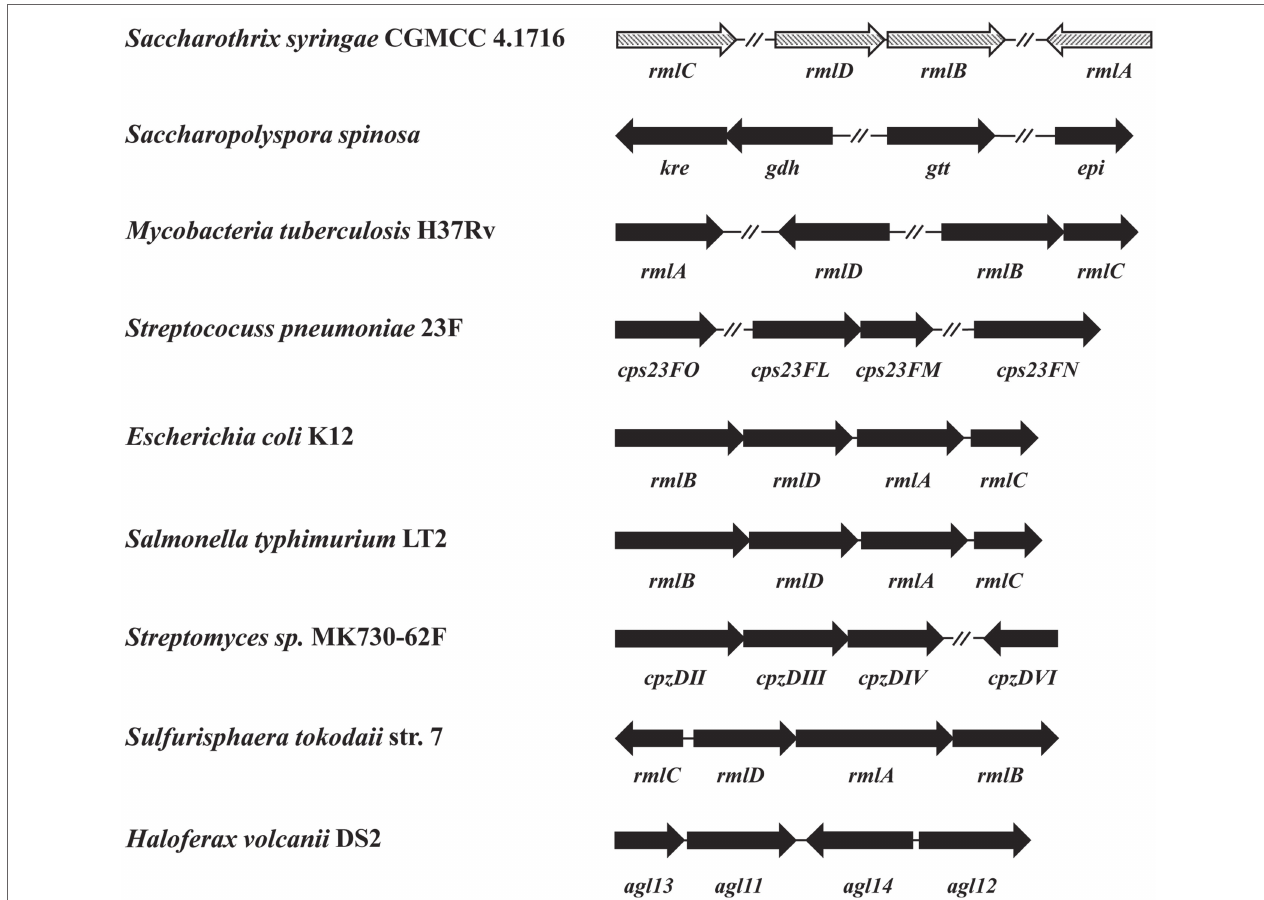
FIGURE 2 | Comparison of nine sets of rmlABCD genes for genomic organization. The sequences for analysis were from Saccharothrix syringae CGMCC 4.1716, Mycobacteria tuberculosis H37Rv (Genbank accession no. NP_214848, NP_217981, NP_217982, and NP_217783) , Saccharopolyspora spinosa (Genbank accession no. AAK83289, AAK83290, AAK83291, and AAK83291), Streptococcus pneumoniae 23F (Genbank accession no. AAZ51352, WP_011285494, WP_012560640, and AAZ51220), E. coli K12 (Genbank accession no. AAB88400, AAB88398, AAB88401, and AAB88399), Salmonella enterica LT2 (Genbank accession no. CAA40117, CAA40115, CAA40118, and CAA40116), Streptomyces sp . MK730-62F (Genbank accession no. ADI50276, ADI50277, ADI50280, and ADI50278), Sulfurisphaera tokodaii str. 7 (Genbank accession no. BAK54697, BAB67067, BAB67064 and BAB67065), and Haloferax volcanii DS2 (Genbank accession no. ADE02576, ADE03524, ADE02686, and ADE02982). The genes were represented by arrows indicating their transcription